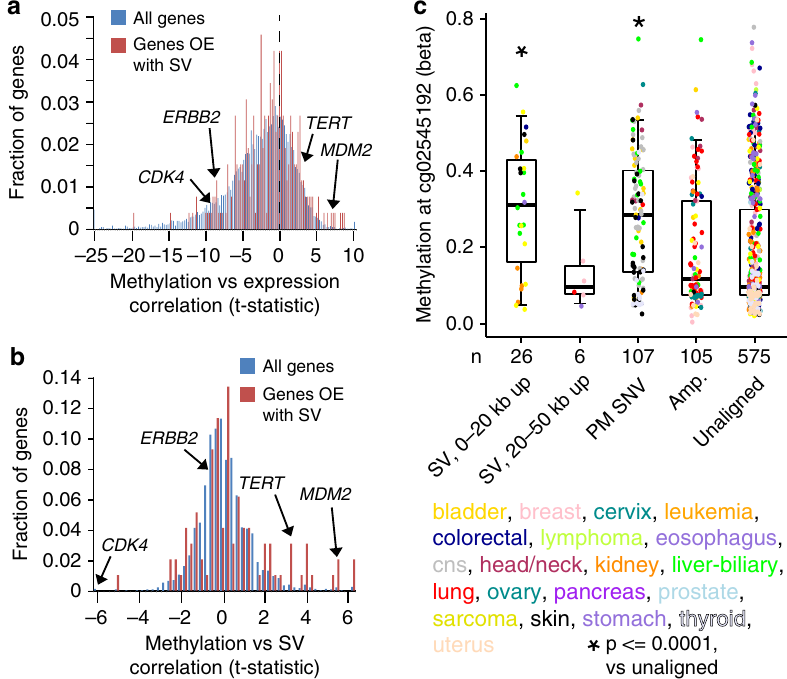
Fig. 6 Altered DNA methylation patterns associated with SV breakpoints near genes. a Histogram of t -statistics for correlation between gene expression and DNA methylation (by Pearson ’ s using log-transformed expression and logit-transformed methylation), for both the entire set of 8256 genes (blue) associated with CpG islands represented on DNA methylation array platform and the subset of 263 genes (red) on methylation platform and positively correlated in expression ( p < 0.001 and FDR < 4%, “ OE ” for “ overexpressed ” ) with occurrence of upstream SV breakpoint (for either 0 – 20 kb, 20 – 50 kb, or 50 – 100 kb SV sets). b Histogram of t -statistics for correlation between gene expression and SV event (by Pearson ’ s using logit-transformed methylation), for both the entire set of 2316 genes (blue) with at least three cases with SV breakpoints 0 – 20 kb upstream and represented on methylation platform and the subset of 97 genes (red) on methylation platform and positively correlated in expression ( p < 0.001 and FDR < 4%) with occurrence of SV breakpoint 0 – 20 kb upstream. c DNA methylation of the CpG site cg02545192 proximal to the TERT core promoter in cases with SV breakpoint 0 – 20 kb or 20 – 50 kb upstream of TERT, in cases with TERT promoter (PM) activation mutation (SNV), in cases with TERT ampli fi cation ( “ amp. ” ), and in the rest of cases (unaligned). P -values by t -test on logit-transformed methylation beta values; “ * ” denotes signi fi cant differences versus unaligned group with p < = 0.0001. Box plots represent 5, 25, 50, 75, and 95%. Points in box plots are colored according to tumor type as indicated. See also Supplementary Data 6 and Supplementary Fig.